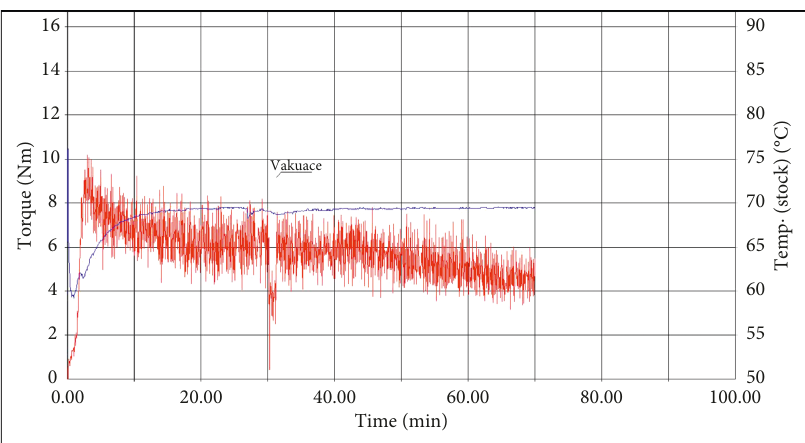
Figure 1: A typical mixing curve of EPX-2R. The blue line represents the temperature of the sample, while the red peaks represent the torque during the mixing process. Table 1: The data required for calculation of detonation characteristics.